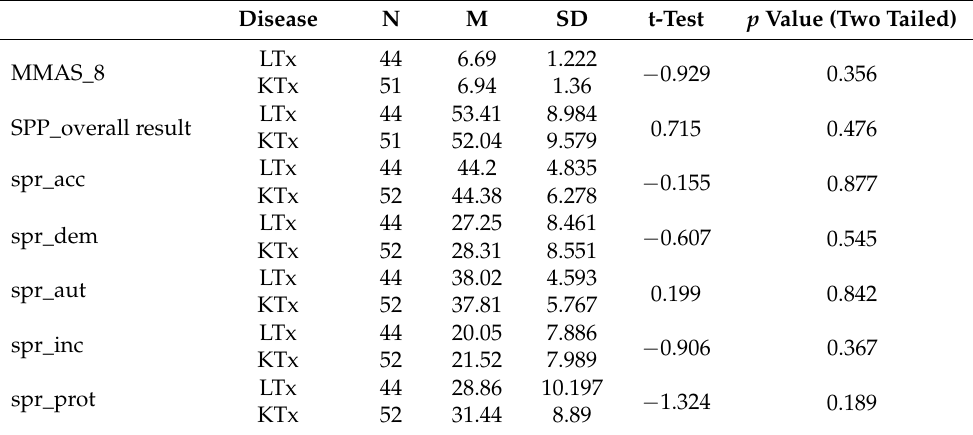
Table 1. Mean values of MMAS-8, resilience and parental attitudes depending on the type of disease. Disease